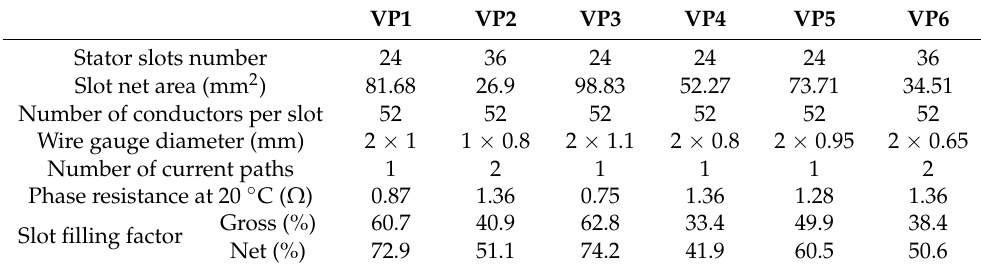
Table 6. Stator winding parameters.